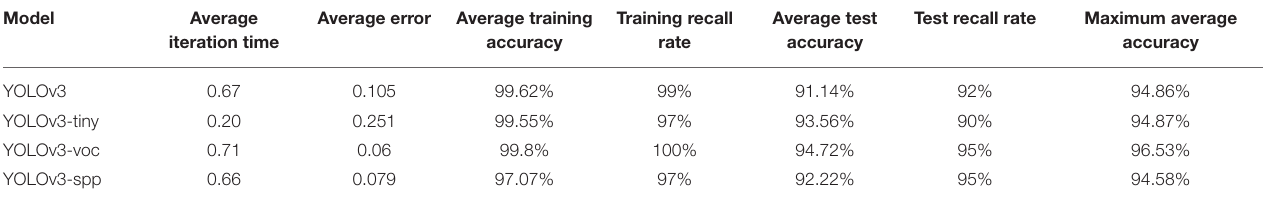
TABLE 3 | Experiment 2-various YOLO models result comparison table (after data augmentation).